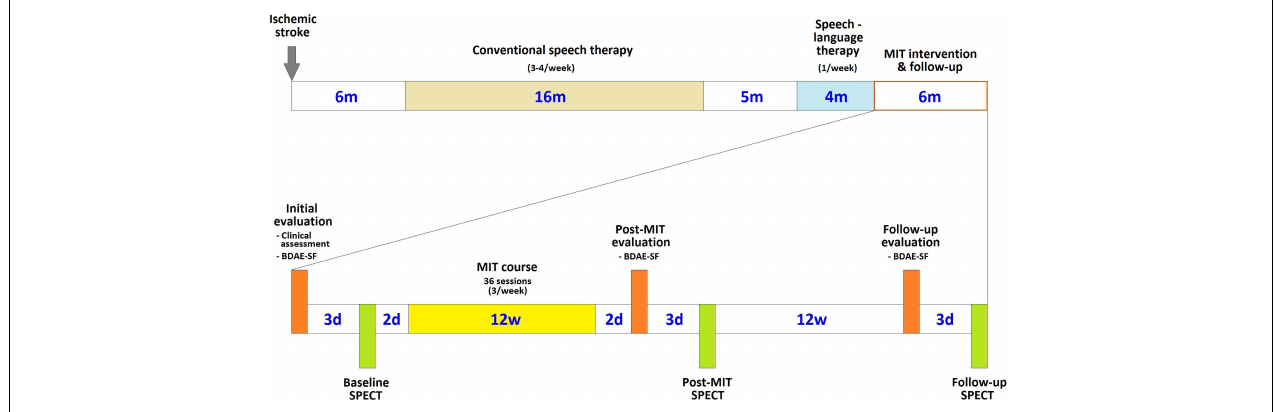
FIGURE 1 | Chronological arrangement of the MIT course and its associated clinical and language assessments and imaging sessions in relation to the patient’s stroke and subsequent therapeutic interventions (d is for days, w for weeks, and m for